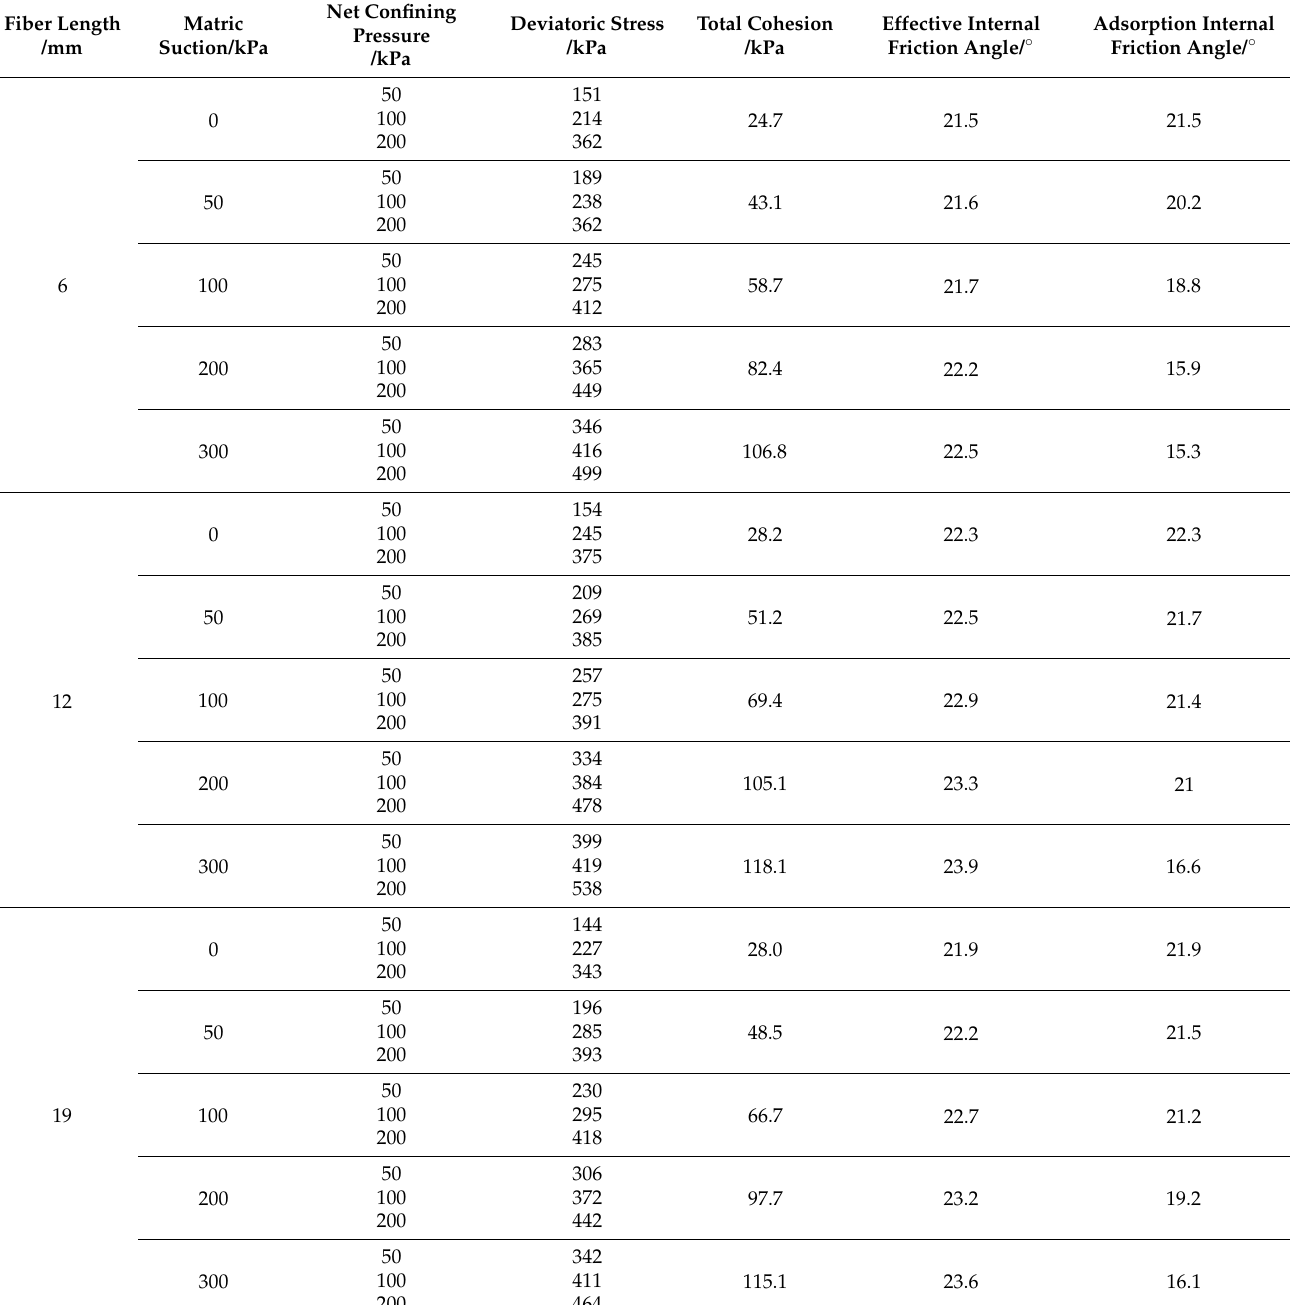
Table 3. Shear characteristics of fiber reinforced unsaturated